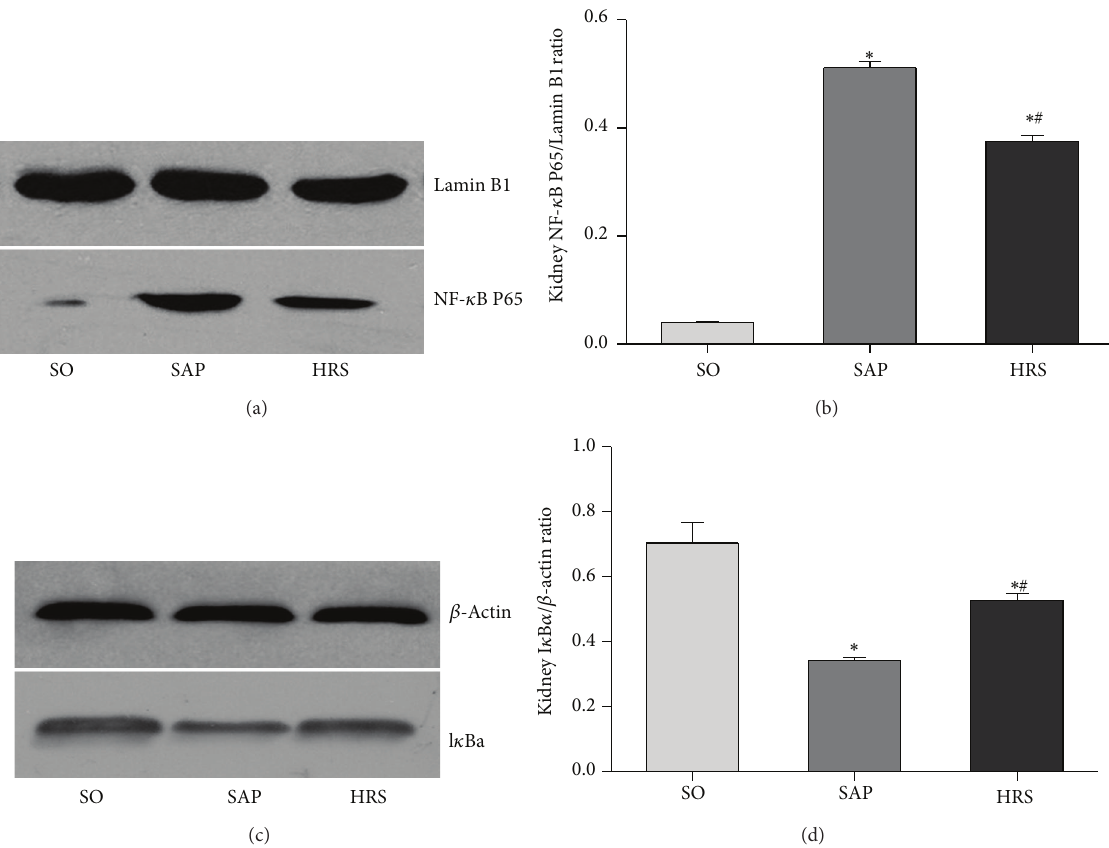
Figure 7: Western blotting for measuring the activation of NF- 𝜅 B p65. (a) Level of NF- 𝜅 B p65 in renal nucleoprotein at 12 hours, (b) densitometric analysis of the bands for the expression of NF- 𝜅 B p65/Lamin B in renal nucleoprotein, (c) level of I 𝜅 B in renal cytoplasmic protein at 12 hours, and (d) densitometric analysis of the bands for the ratio of I 𝜅 B/ 𝛽 -actin in renal nucleoprotein. Results are expressed as mean (SD), 8 rats per group. ∗ 𝑃 < 0.05 versus respective SO group; # 𝑃 < 0.05 versus respective SAP